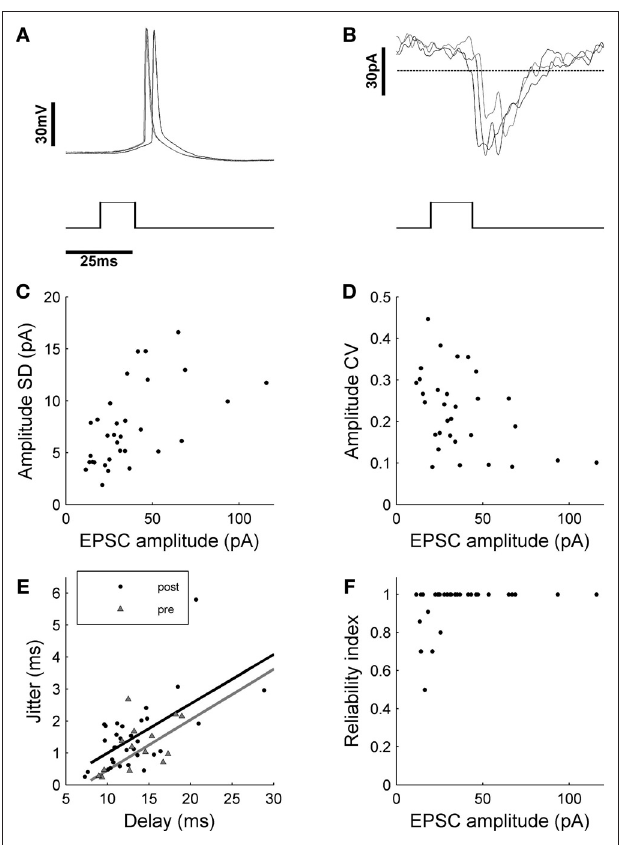
FIGURE 3 | Quantifi cation of synaptic variability. (A) Single-shot stimulation of presynaptic cells evoked action potentials with a reliability of 100% ( n = 14 cells). (B) In the postsynaptic cell, isolated PSCs could be detected, which were quantifi ed in terms of absolute and relative amplitude variability (C,D) . The long absolute latencies of up to 30 ms after stimulus onset, which became apparent when temporal jitter of PSC onset (fi lled circles) was evaluated (E) , originated largely from the presynaptic spike formation, as tested with direct shots to the somata of cells patched in different layers of the slice tissue (grey triangles). Fitting linear regression lines to the data points representing either pre- or postsynaptic events, showed that latency jitter was mainly due to the process of presynaptic spike formation. Actual temporal jitter of synaptic transmission could be estimated as the difference in intercept of the linear regression lines with the y-axis, which yields a low temporal jitter of 0.57 ms. (F) Reliability of synapses was very high, possibly because of multiple synapses per cell-to cell